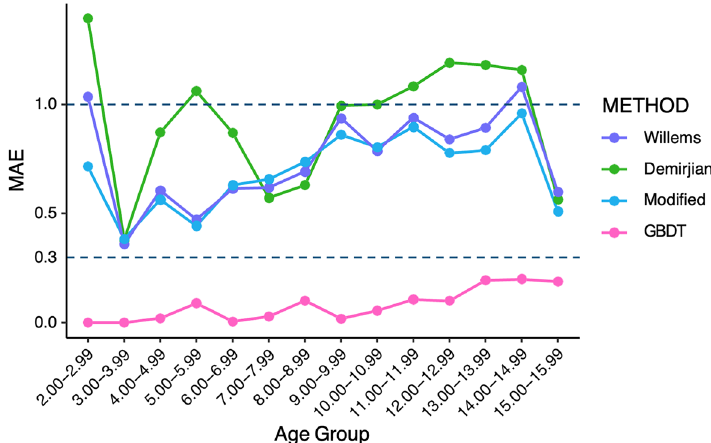
Figure 4. Error in estimating dental age by different methods in male groups (2–16 years).